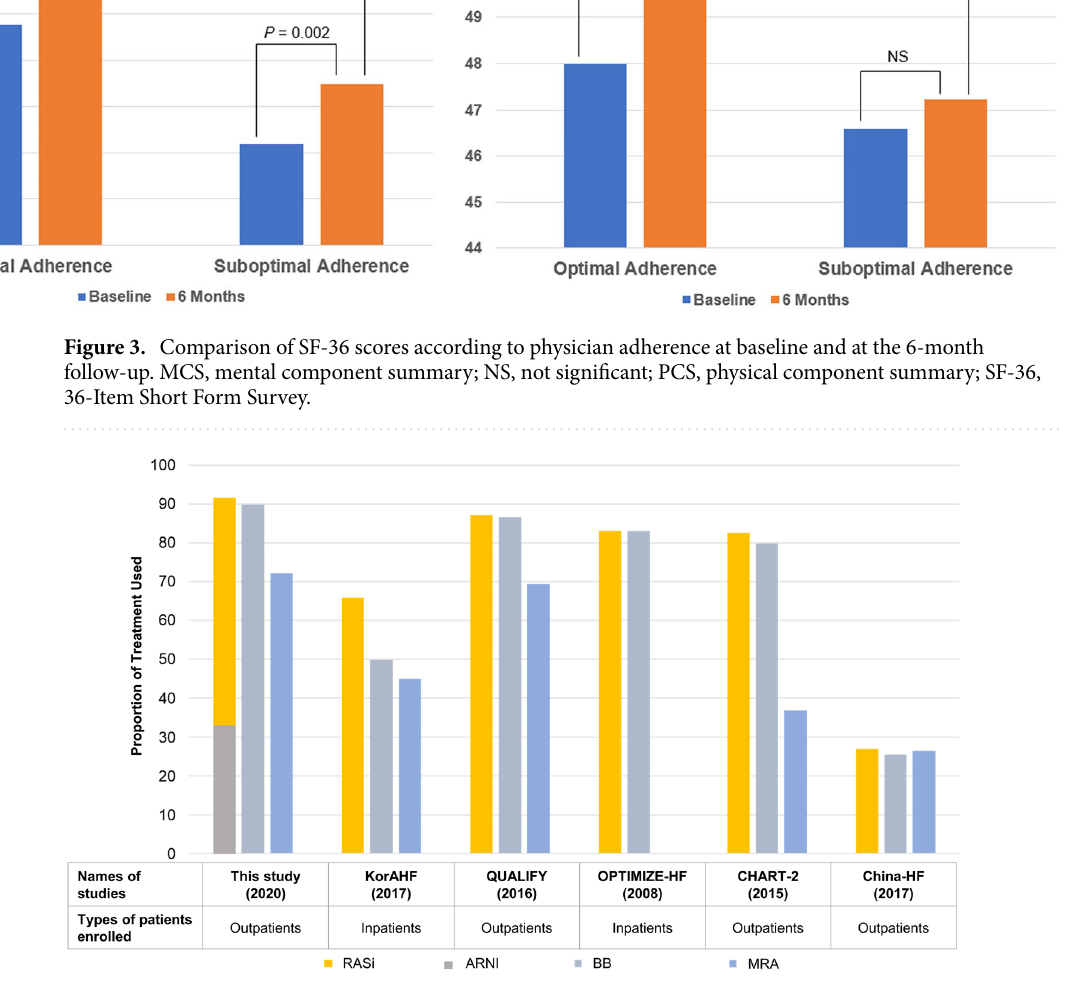
Figure 4. Comparison of physician adherence in this study with previous heart failure registry studies. ARNI, angiotensin receptor-neprilysin inhibitor; BB, beta-blocker; MRA, mineralocorticoid receptor antagonist; RASi, renin–angiotensin–aldosterone system